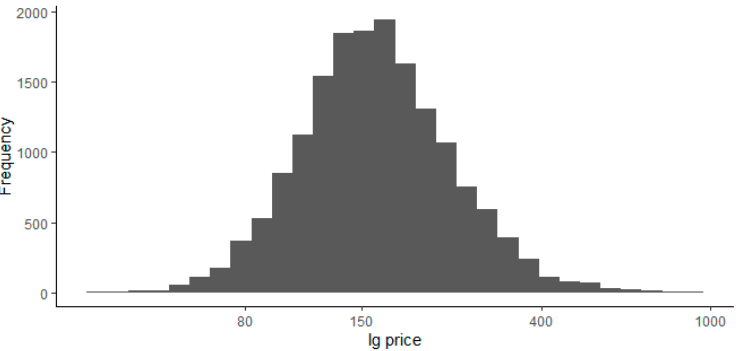
Figure 1. Histogram of lg𝑝𝑟𝑖𝑐𝑒 .